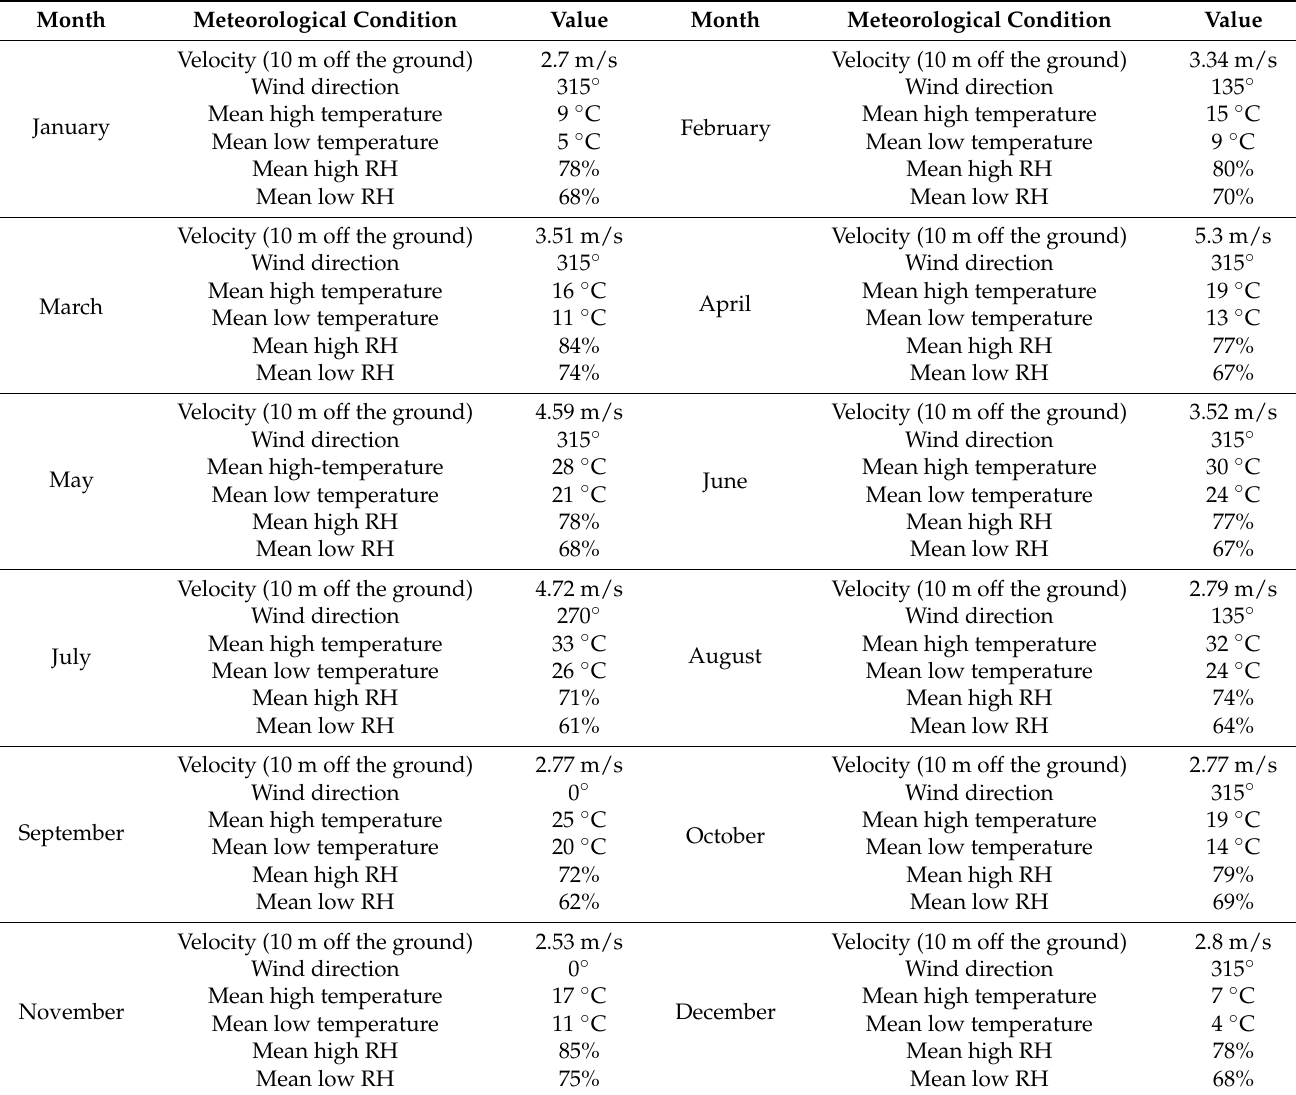
Table 4. Boundary conditions of